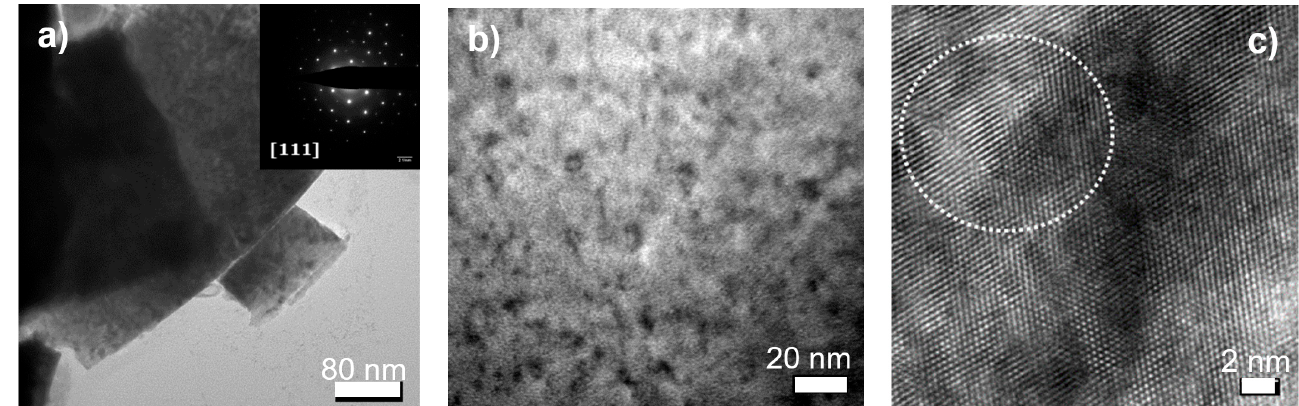
Figure 6. TEM bright field image ( a , b ) of sample SF4 (4.9 dpa) showing dislocation loops habiting the [111] plane, as shown by the electron diffraction in the inset of ( a ). ( c ) HRTEM image showing a single loop of approximately 5 nm diameter (circled by white dots).